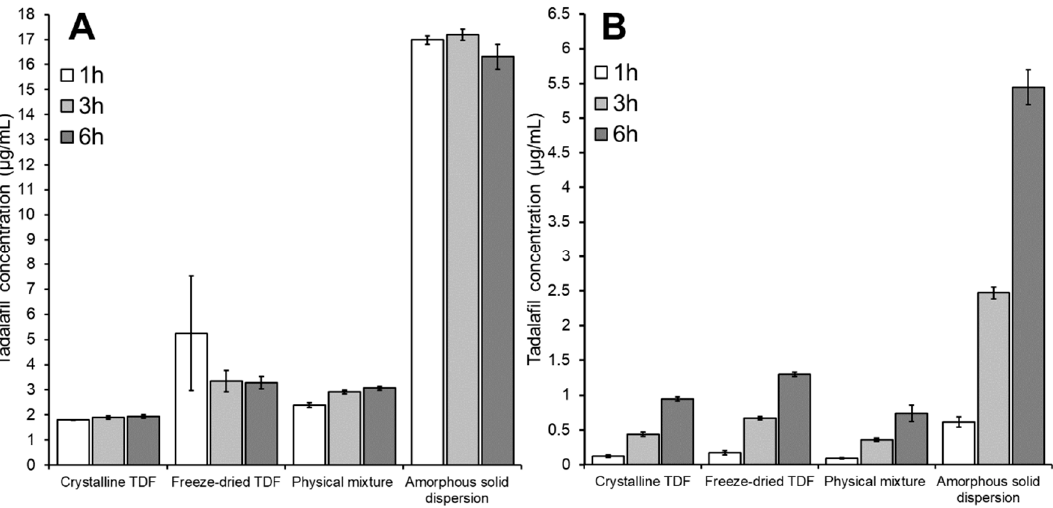
Figure 6. Tadalafil concentration in ( A ) the donor compartment and ( B ) the acceptor compartment after 1, 3 and 6 h of incubation when using different tadalafil formulations dispersed in 50 mM phosphate buffer as donor. The acceptor medium was 1% Vitamin E TPGS in 50 mM phosphate buffer. Data shown as mean ± SD of four replicates.